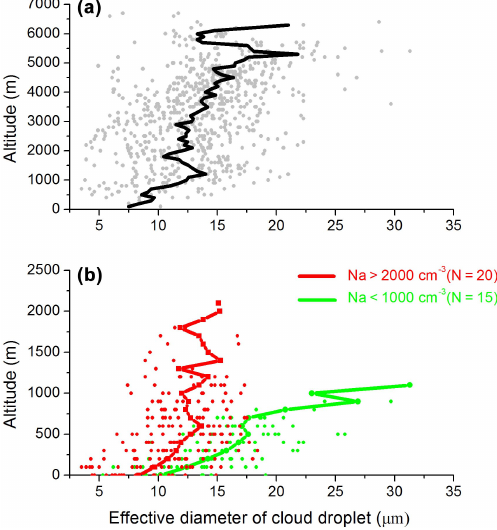
Figure 11. The vertical profiles of (a) sampling cloud droplet size detected by 40 aircraft, and (b) changes in number of diameters of cloud droplets under low and high aerosol number